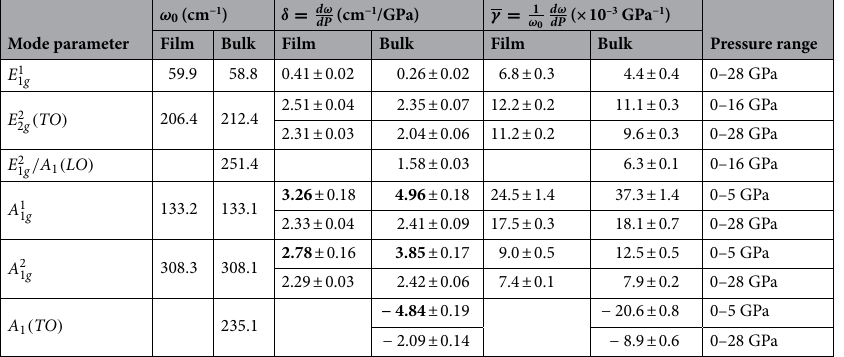
Table 2. Experimental ambient-pressure frequency ( ω 0 ), pressure coefficient ( δ ), and Grüineisen parameter ( γ ) of the Raman active modes observed from the SDD-GaSe film and the GaSe bulk. The bold values indicate the highlighted pressure coefficients of out-of-plane Raman active modes in the SDDGaSe film and bulk at a low-pressure range (< 5